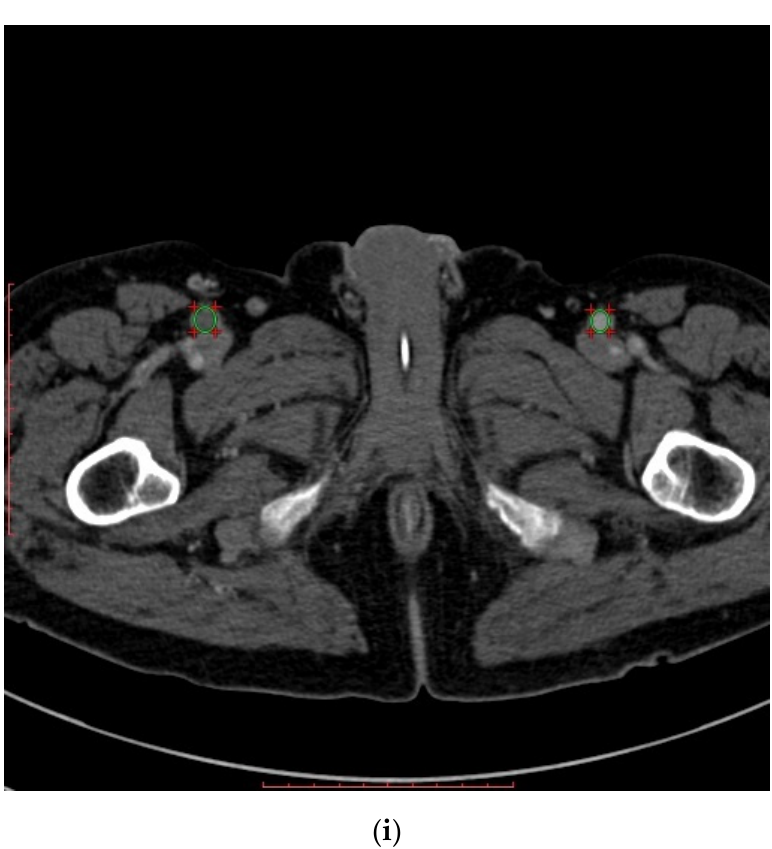
Figure 1. Computed tomography angiography images: ( a ) dilation of the right and left pulmonary arteries with a borderline width of the pulmonary trunk; ( b ) left pulmonary artery filling defect suggesting presence of embolic material; ( c ) non-uniform aortic density suggesting acute aortic syndrome; ( d ) aneurysm of the ascending aorta, aortic arch and proximal part of the descending aorta; ( e ) aortic aneurysm with massive parietal thrombi/aortic aneurysm with chronic dissection and clotting of the supposedly dissected canal; ( f ) angular (Gothic) aortic arch; ( g ) stenosis of the proximal section of the superior mesenteric artery; ( h ) occlusion of the proximal section of the right superficial femoral artery; ( i ) filling defects in the veins of the right iliac axis that is most probably a thrombotic